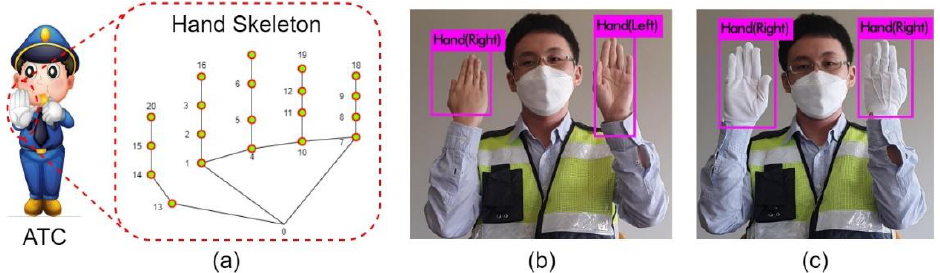
Figure 3. Illustration of the traffic control hand gesture and the associated problem with gloves: ( a ) hand landmark skeleton of the authorized traffic controller (ATC). Hand traffic gesture detection: ( b ) without gloves and ( c ) with gloves.